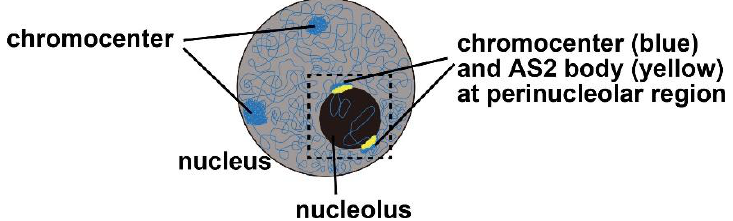
Figure 4. Schematic representation of the nucleus is shown. Chromosomes and AS2 bodies are indicated by blue and yellow, respectively. AS1 and AS2 are co-localized on AS2 bodies.